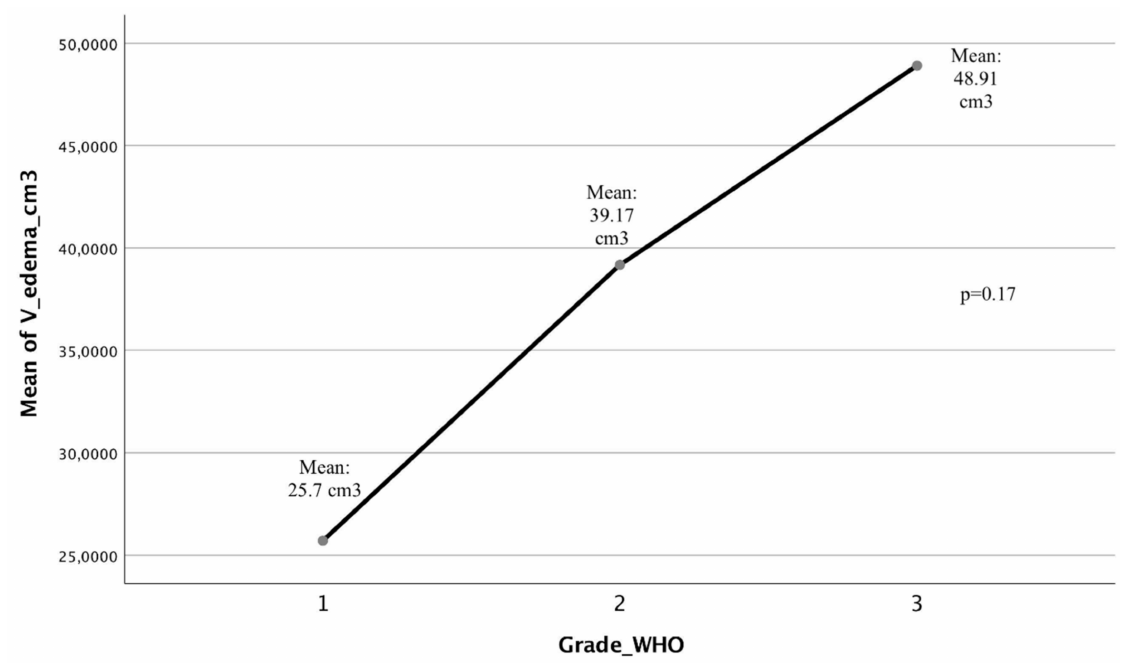
Figure 6. The one-way ANOVA study demonstrates a linear relationship between edema volume and meningioma grading, with low significance ( p = 0.167).